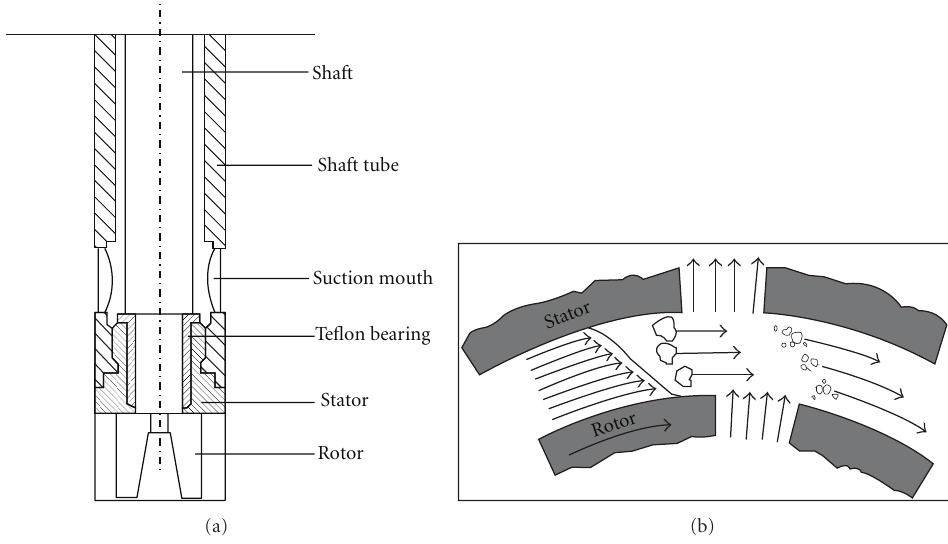
Figure 2: Cross-section of high-speed homogenizer (a) and mechanism of rotor-stator (b).